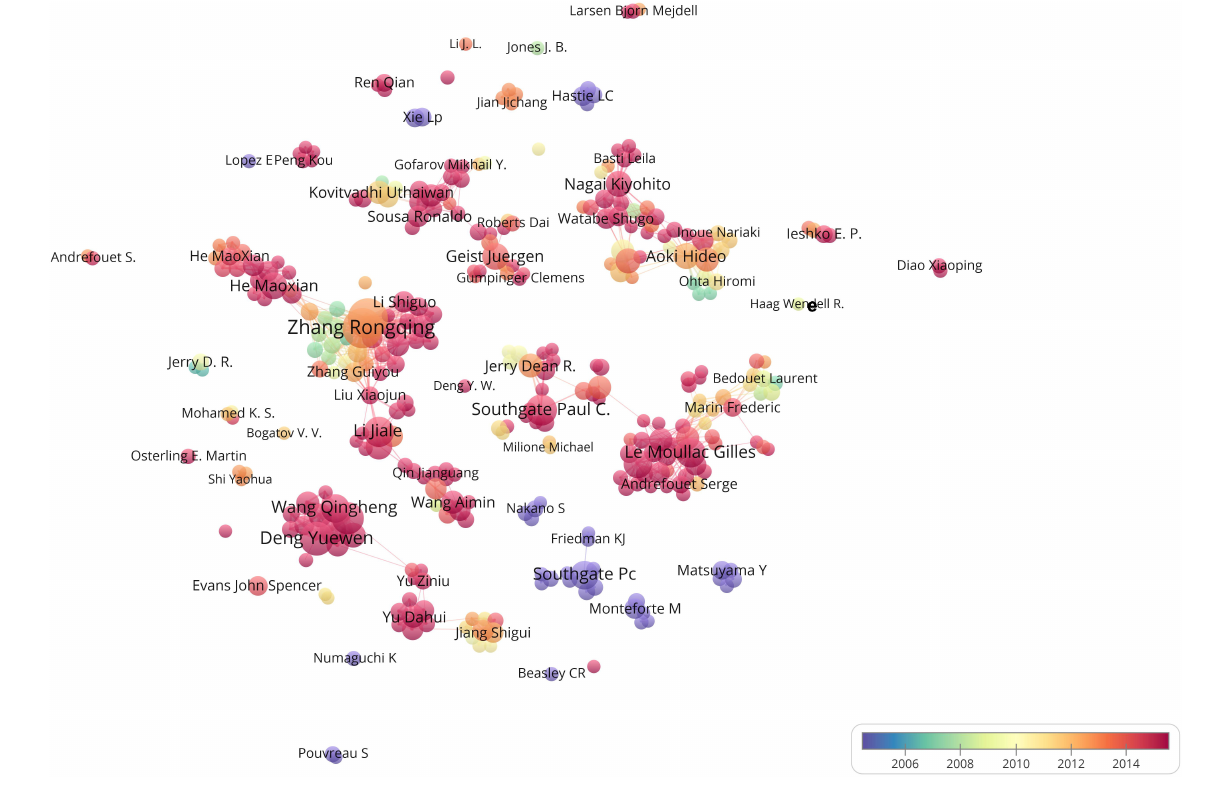
breeding program for pearl farmers. Van Wynsberge et al.